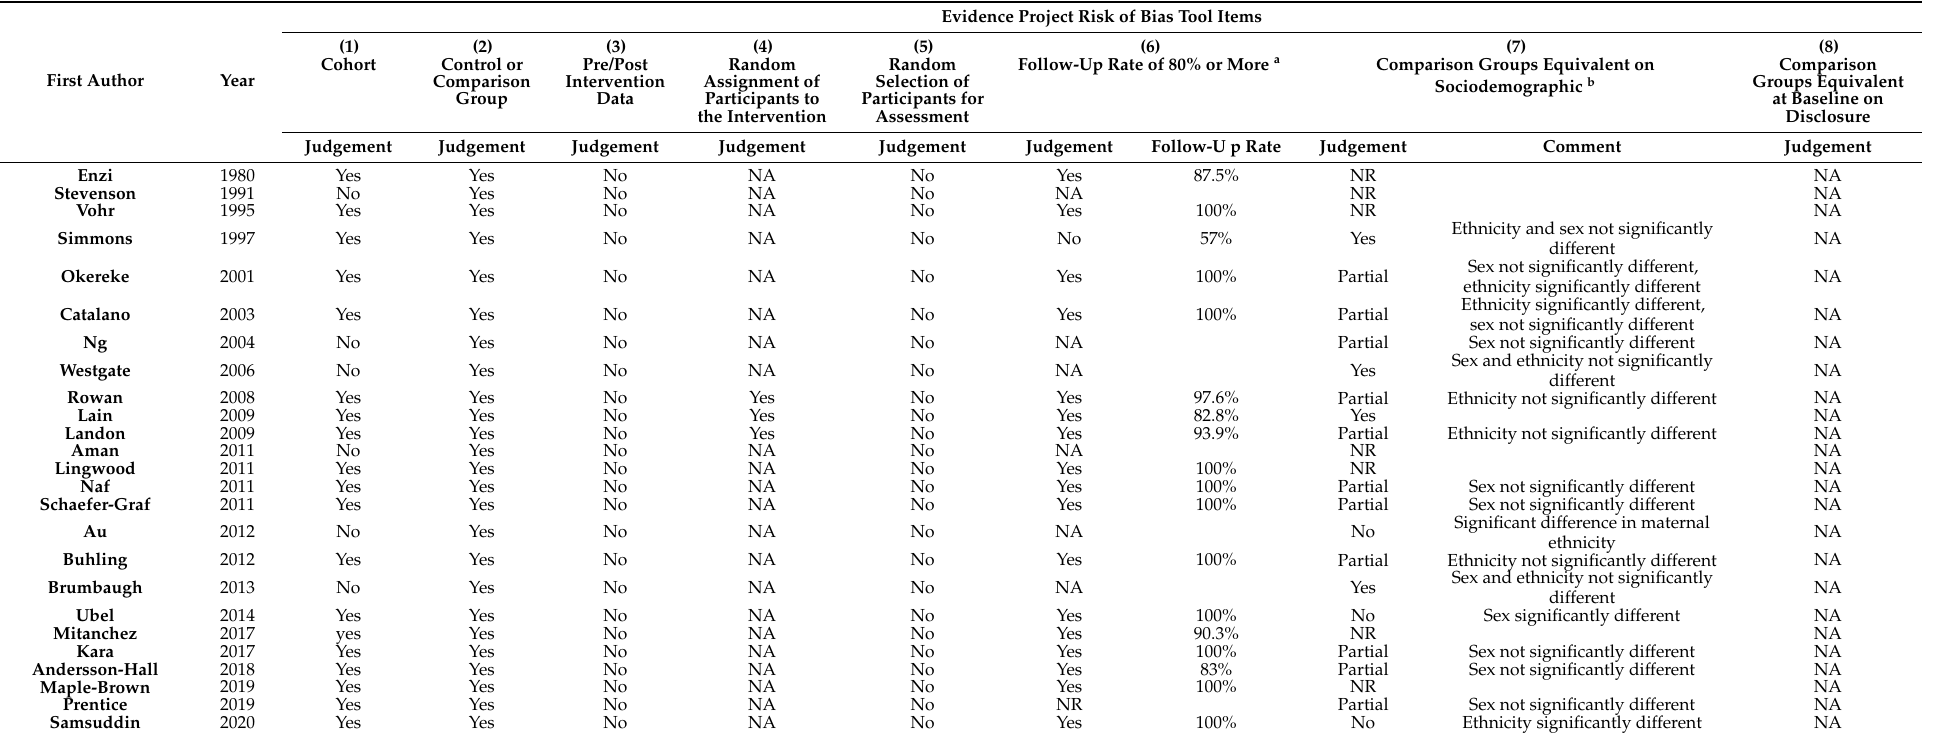
Table 2. Quality assessment of the studies included in the review, using the Evidence Project risk of bias